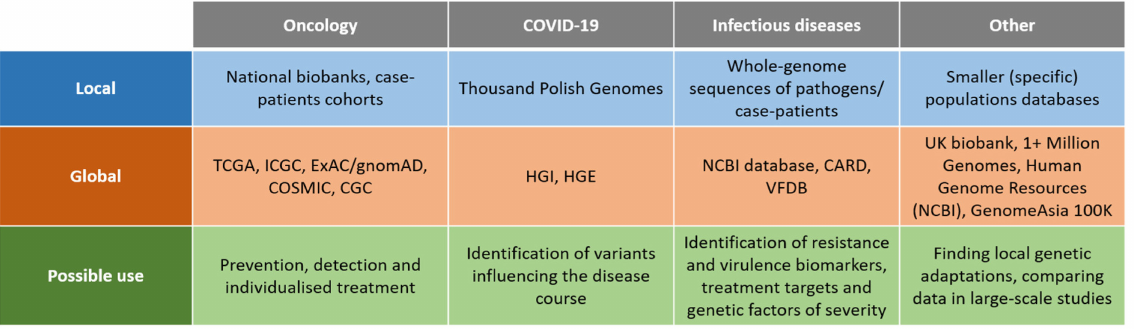
Figure 3. Sources of genomic data (existing databases) described in the review. Note that not all of the databases mentioned above contain WGS-derived data; some of them were created on the basis of other